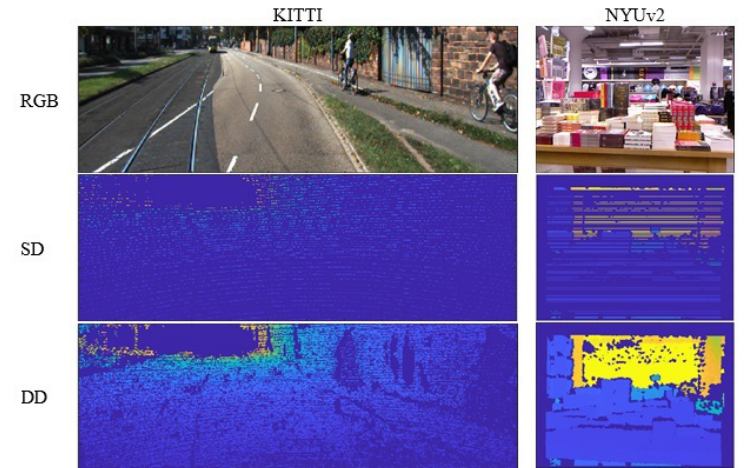
Figure 6. A sample of the used